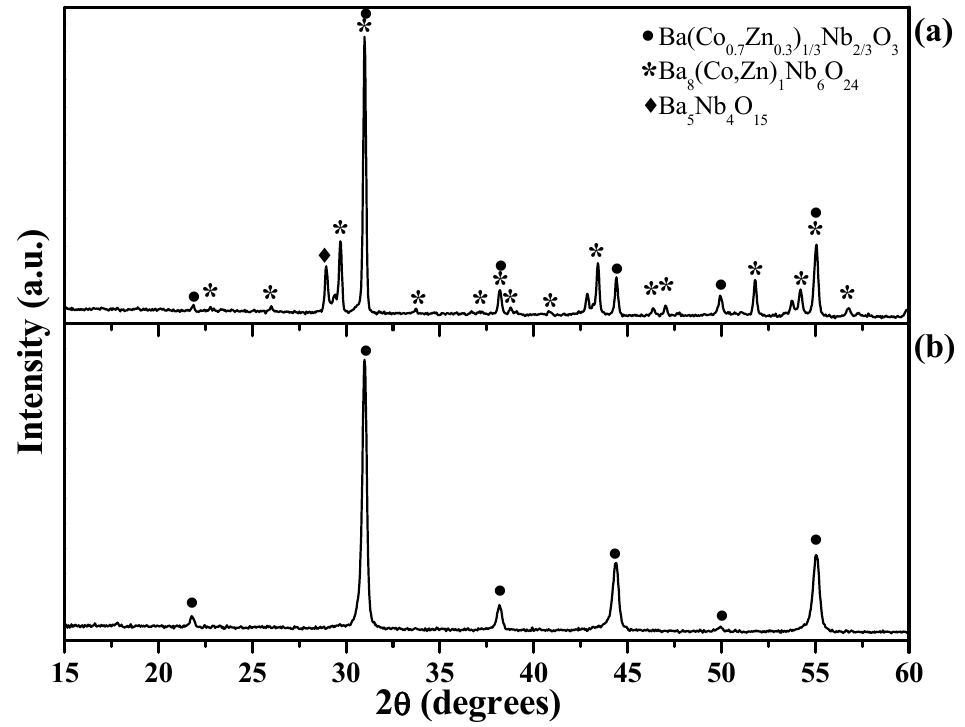
Figure 4. X-ray diffractograms of a BCZN ceramic ( S2 ): ( a ) at the upper surface and ( b ) at a depth of 120 µm below the surface. •: Ba(Co 0.7 Zn 0.3 ) 1/3 Nb 2/3 O 3 ; * : Ba 8 (Co,Zn) 1 Nb 6 O 24 ; ♦ : Ba 5 Nb 4 O 15 .